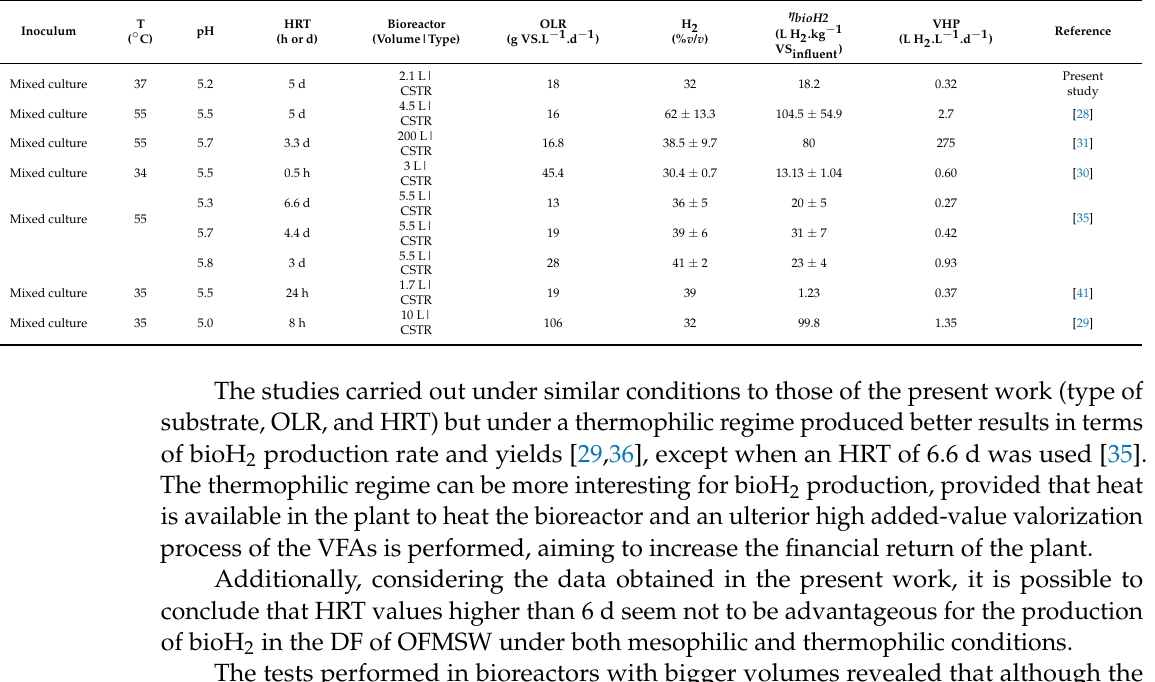
Table 7. Comparison of the main experimental data obtained in the present work with the data available in some bibliographic